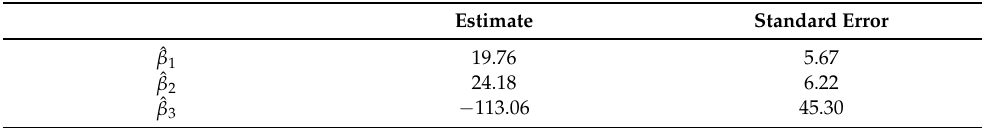
Table A3. Coefficient estimates for BRCAPRO + BCRAT (E2).